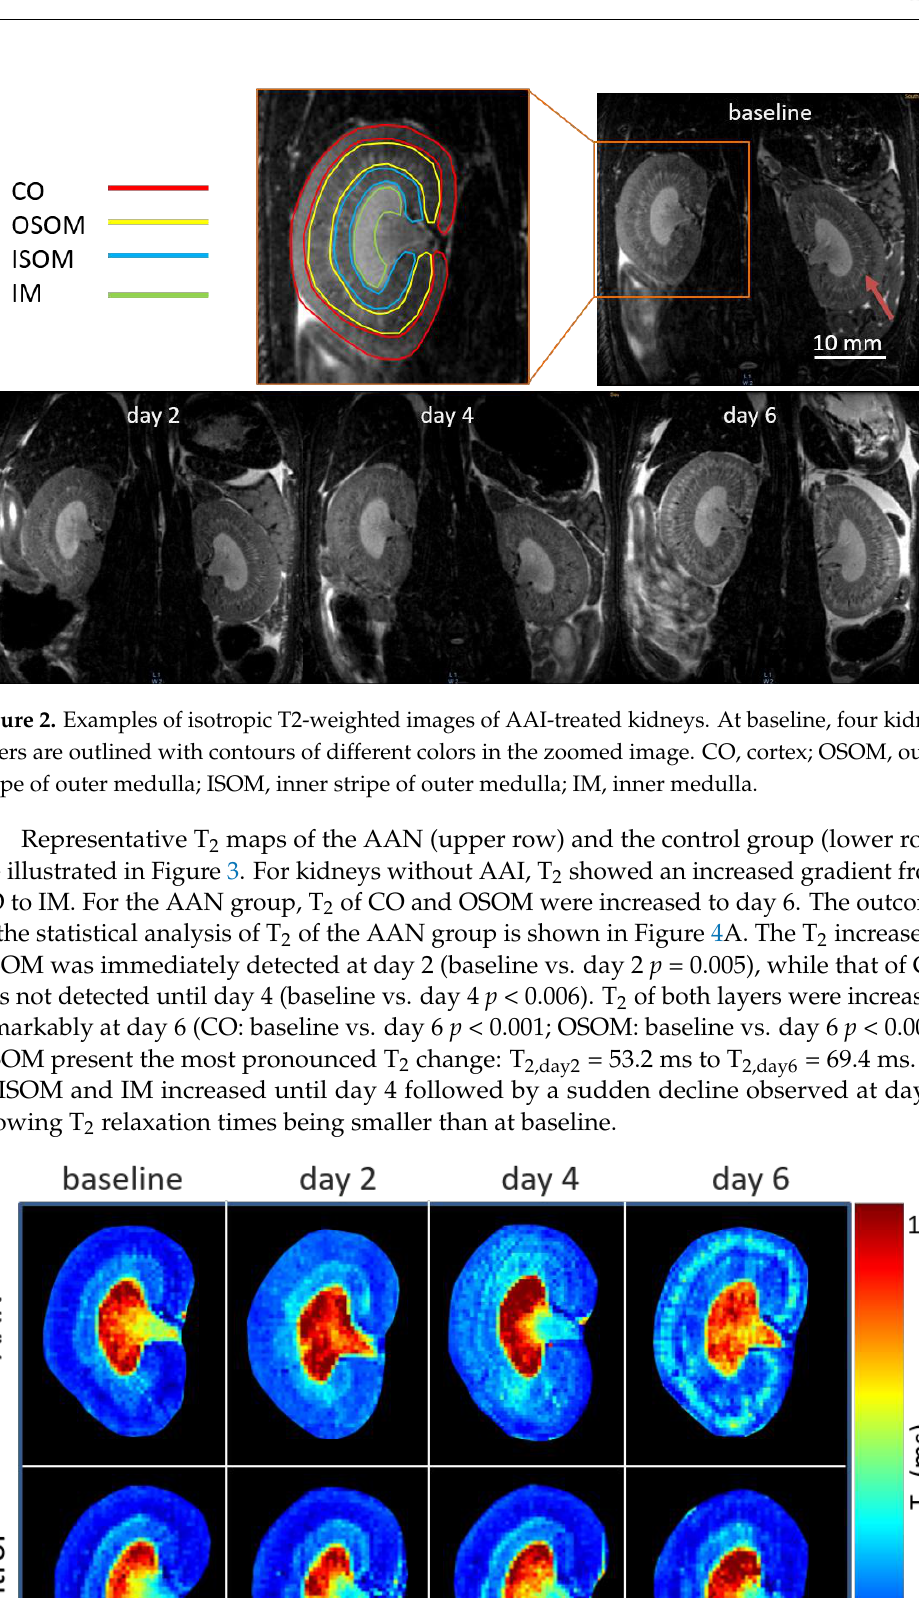
Figure 4. Statistical analysis of T2 relaxation times for the AAN group ( A ) and the control group ( B ). *** p < 0.001, ** p < 0.01, * p < 0.05. CO, cortex; OSOM, outer stripe of outer medulla; ISOM, inner stripe of outer medulla; IM, inner medulla. The comparison between T 2 derived from the AAN and the control group is shown in Figure 4B. For the control group, T 2 remained stable from baseline to day 6 for all four renal layers. T 2 of CO and OSOM was significantly higher in AAN than in the control group at day 4 and day 6 (CO: day 4 p = 0.002 and day 6 p < 0.001; OSOM: day 4 p = 0.009, day 6 p < 0.001 and p < 0.001). ISOM showed a T 2 reduction ( p = 0.013) only at day 6 if benchmarked against the control group. For IM, no significant T 2 difference was detected between the AAN group and the control group. The T 2 relaxation times of the AAN and the control group are summarized in Table 1. The ADCs obtained for the AAN and the control group are summarized in Table 2. The results derived from the statistical analysis of the ADCs of the AAN group are shown